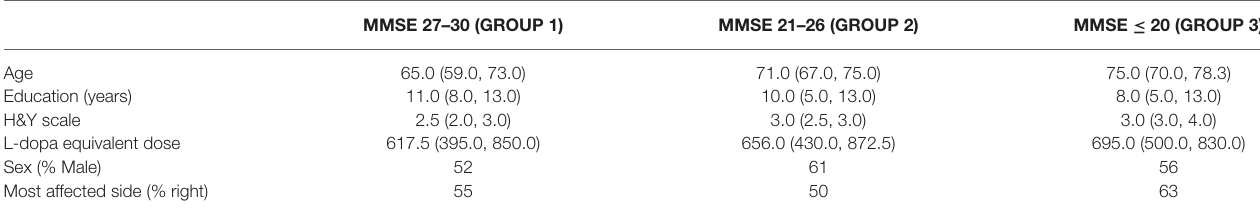
TABLE 1 | Demographical and clinical data of patients subdivided according to